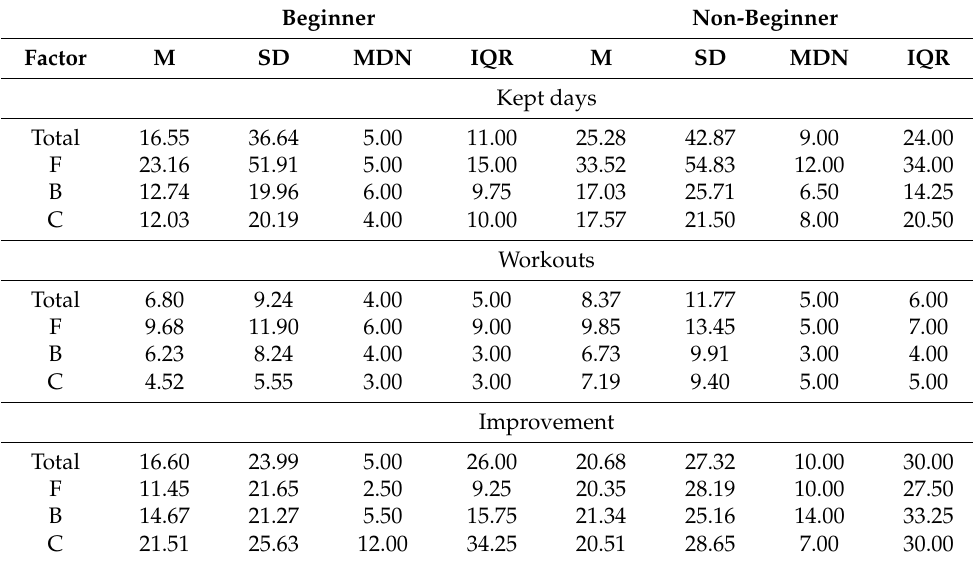
Table 7. Descriptive statistics (split groups). The table shows the descriptive statistics of the kept days, workouts, and improvement in the two groups (i.e., total) and in the two groups considering the different app versions. Beginner Non-Beginner